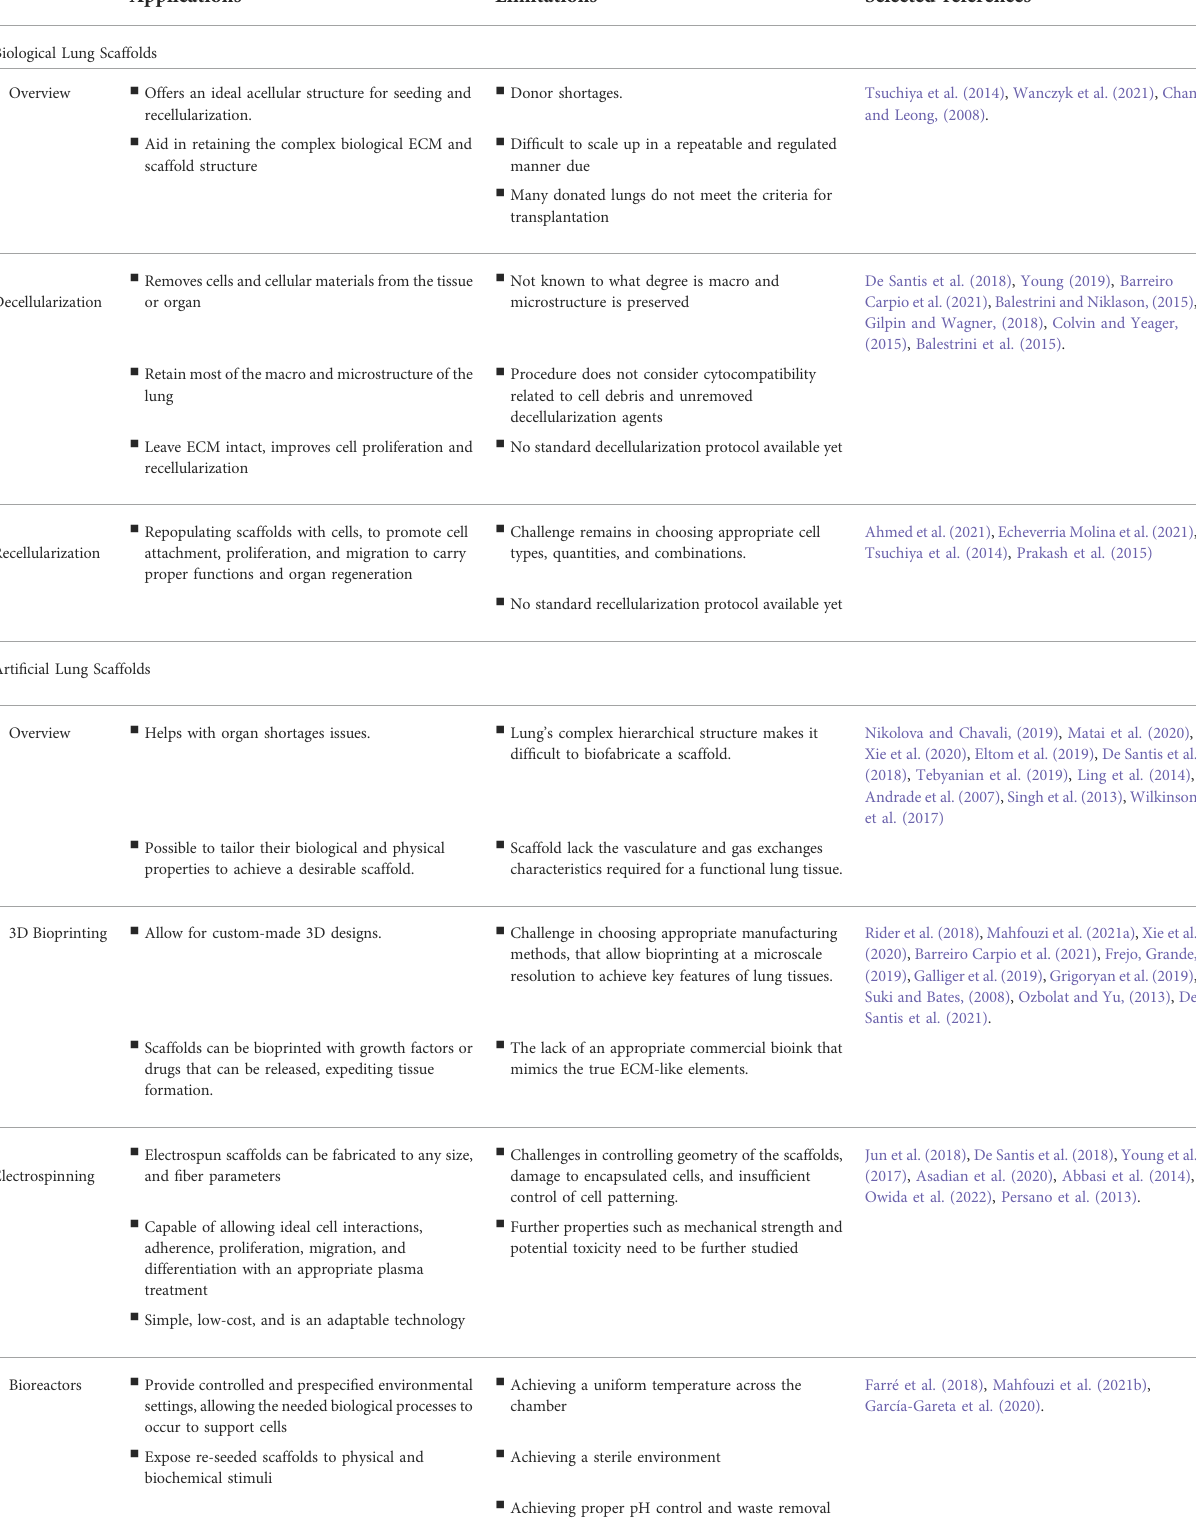
TABLE 1 Summary of lungs bioengineering emerging concepts and procedures, and their main applications and